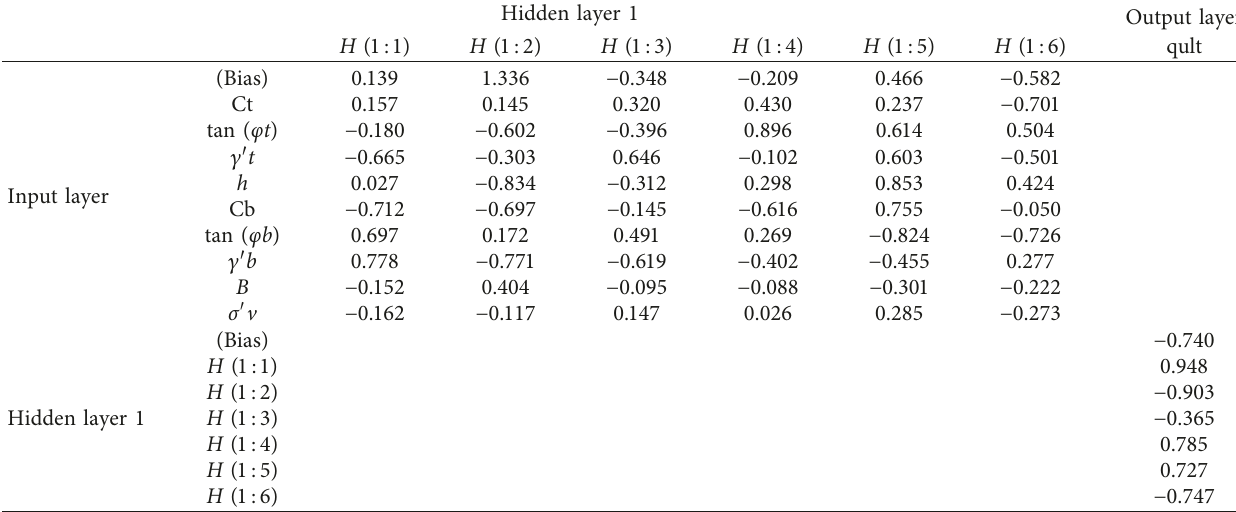
Table 4: Weights matrix for the developed ANN model.